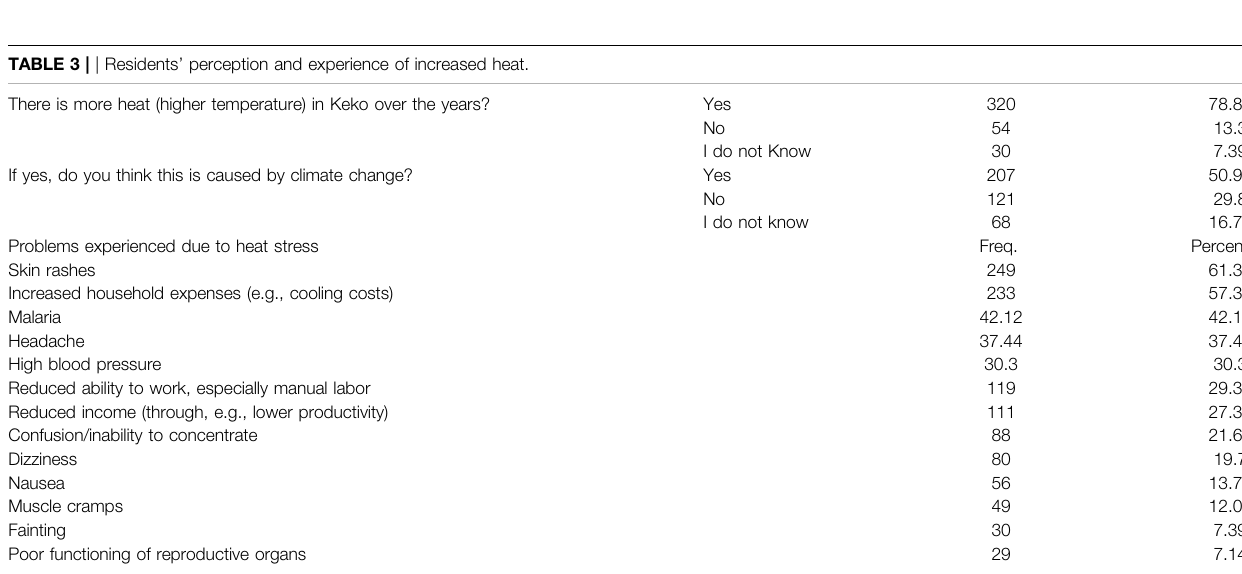
TABLE 3 | | Residents ’ perception and experience of increased heat. There is more heat (higher temperature) in Keko over the